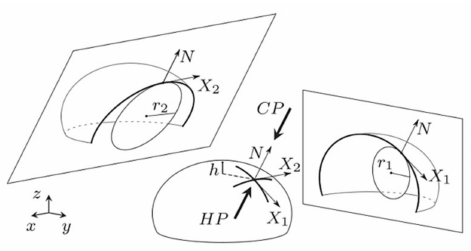
Figure 32. Molten pool surface under the action of forces. Reprinted from Ref. [75].